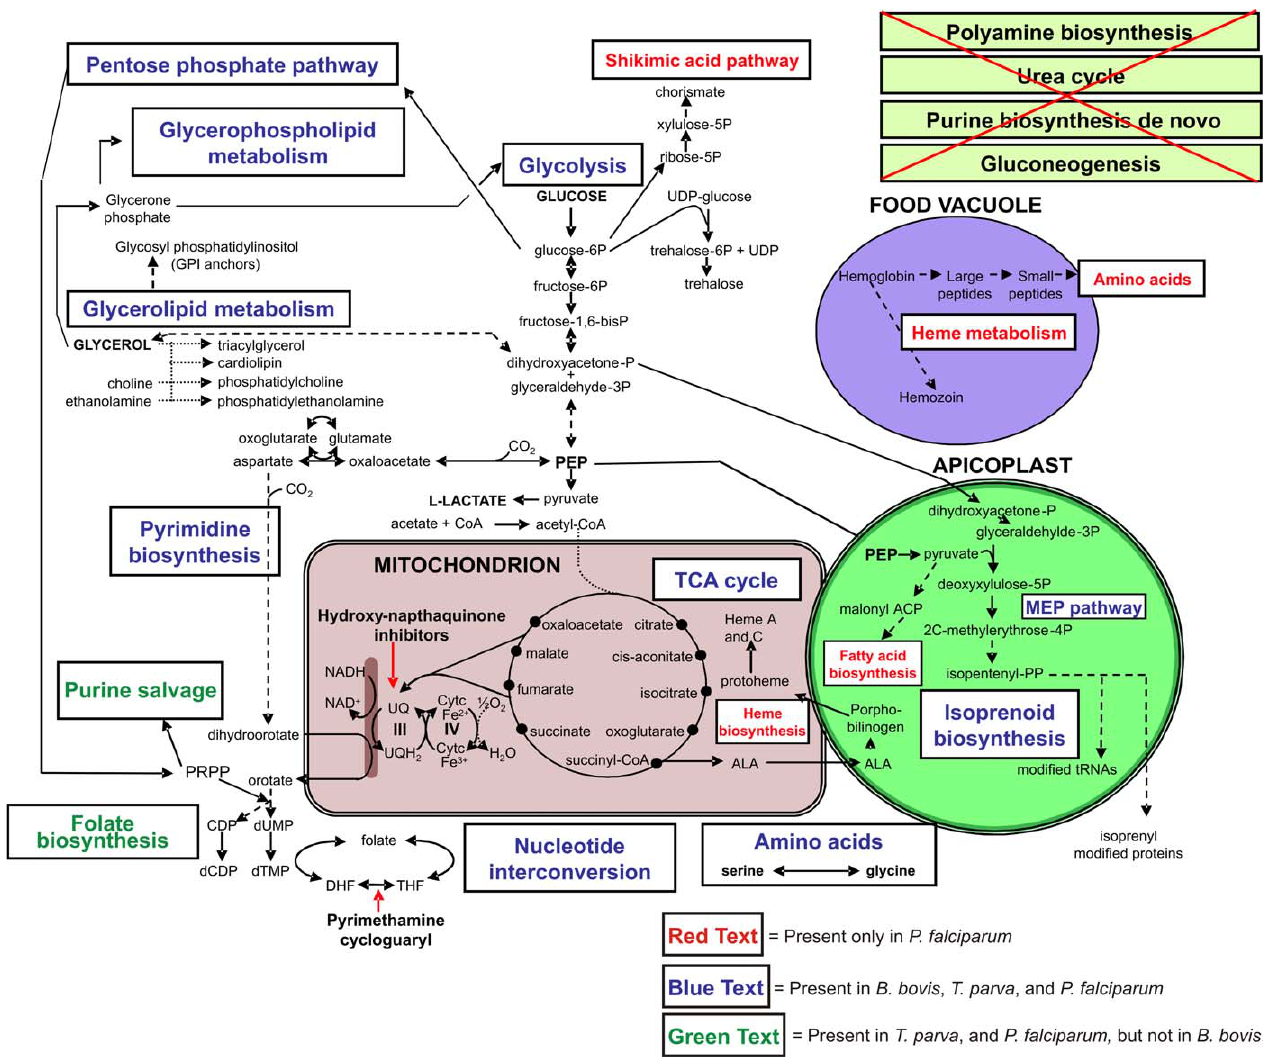
Figure 2. Comparison of Major Metabolic Pathways in B. bovis , T. parva , and P. falciparum Solid arrows indicate single step enzymatic reactions, dashed lines indicate multi-step reactions, and dotted lines indicate incomplete or unknown pathways. Inhibitory drugs are indicated with red arrows. Glucose is assumed to be the major carbon and energy source. Non-functional pathways in P. falciparum , T. parva , and B. bovis are shown in boxes with a red X. Pathways denoted with blue text are present in P. falciparum , T. parva , and B. bovis . Pathways denoted with green text are present in P. falciparum and T. parva but not in B. bovis , and pathways denoted with red text are exclusively found in P. falciparum .